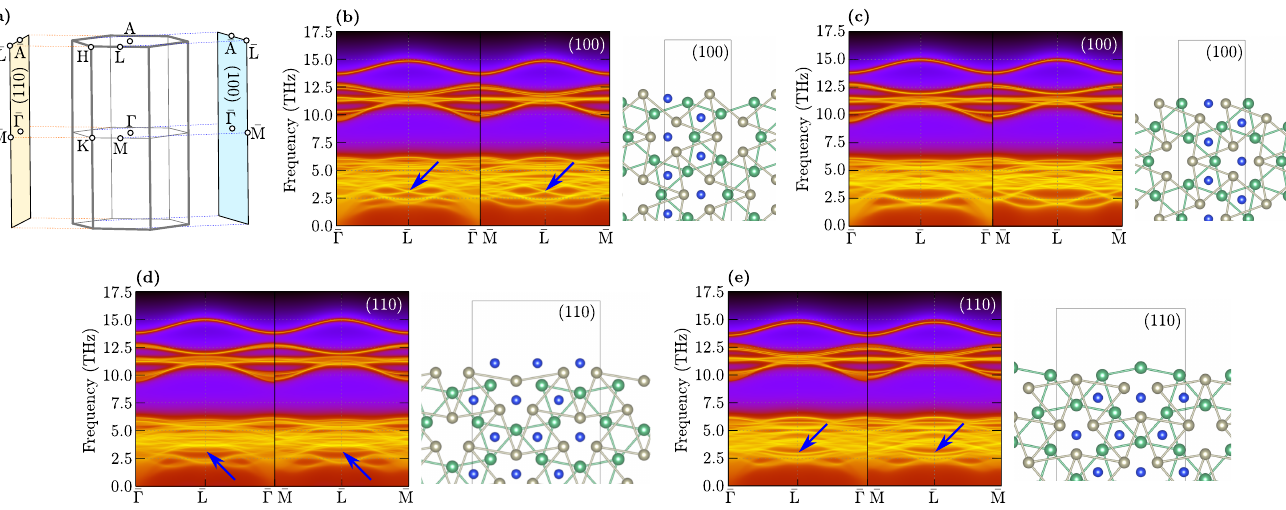
Figure 4. Projection of the 3D bulk Brillouin zone on the 2D surface Brillouin zones for (100) and (110) surfaces ( a ). Panels ( b – e ) present surface Green functions for different surfaces (as labeled) and corresponding terminations (right schemats). Blue arrows show phonon surface states at ¯L point.